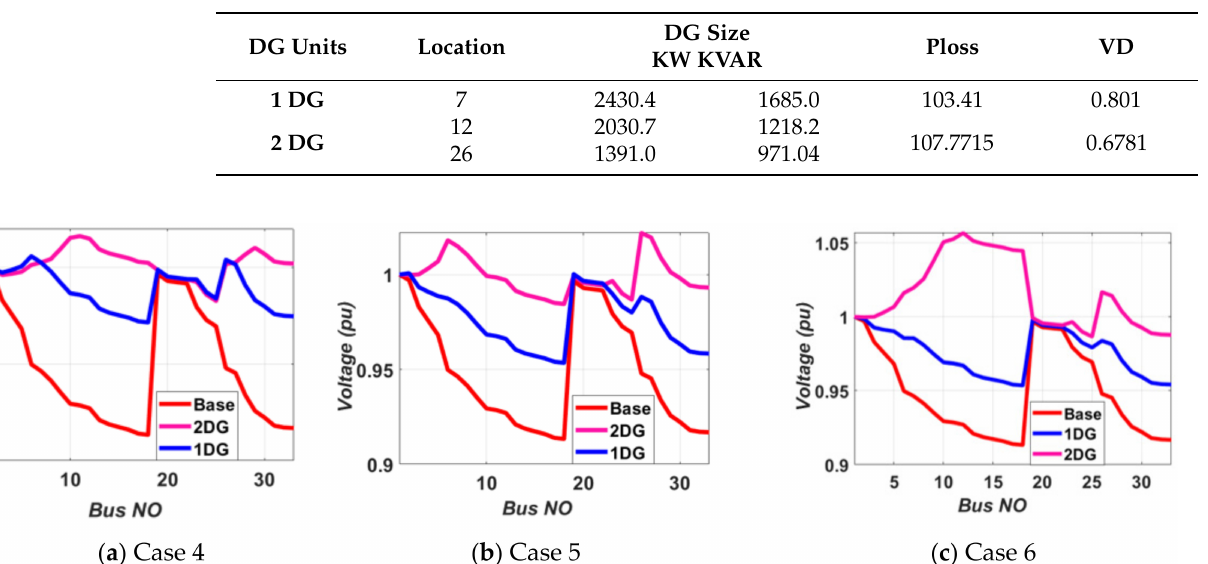
Table 19. Case 6: optimal DG III allocation based on loss minimization and voltage deviation.